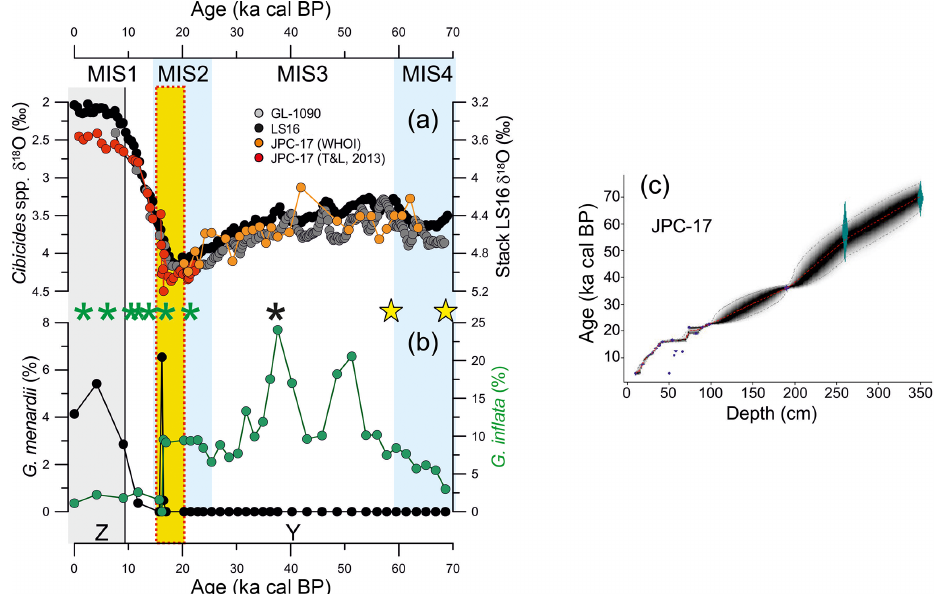
Figure 2. Age model of core JPC-17. (a) Comparison between the benthic foraminifera δ 18 O record of JPC-17 – composed of published Cibicidoides spp. (Tessin and Lund, 2013; T&L, 2013) and unpublished Cibicidoides spp. data from Woods Hole Oceanographic Institution (WHOI) – to the benthic foraminifera δ 18 O record of core GL-1090 (Santos et al., 2017) as well as to the intermediate-depth South Atlantic benthic δ 18 O stack LS16 (Lisiecki and Stern, 2016). Asterisks represent the calibrated radiocarbon ages published in (green) Tessin and Lund (2013) and (black) Portilho-Ramos et al. (2014b), whereas yellow stars represent the δ 18 O tie points shown in Table 1. (b) Abundance of the main biostratigraphical planktonic foraminifera species Globorotalia menardii and Globorotalia inflata from core JPC-17. Marine Isotopic Stages 1–4 (MIS1–4; MIS2 and MIS4 indicated by vertical blue bars) are shown at the top, whereas “Z” (vertical grey bar) and “Y” in the bottom correspond to biostratigraphical biozones from Ericson and Wollin (1968). (c) Age–depth model based on Bacon v. 2.2 (Blaauw and Christen, 2011). The symbols represent the positions of the calibrated AMS 14 C ages benthic δ 18 O tie points listed in Table 1. Error estimations of the δ 18 O tie points follow Santos et al. (2017) and take into account the mean resolution of the JPC-17 benthic δ 18 O record around the tie-point depth, the mean resolution of the reference curve around the tie-point age, a matching error visually estimated when defining tie points and the absolute age error of the timescale used for the reference record. The vertical yellow bar marks the interval with reversed radiocarbon ages listed in Table